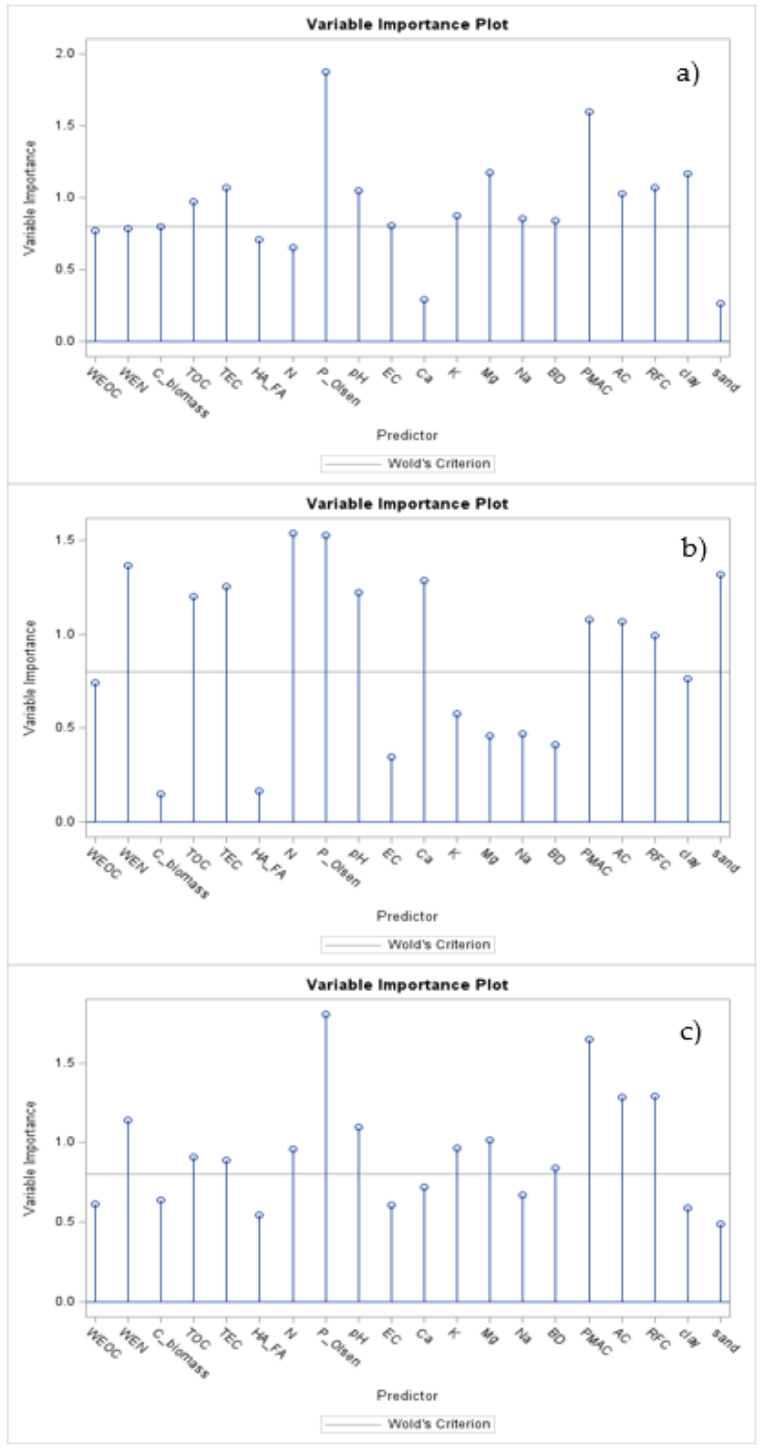
Figure 3. Variable importance for projection statistics (PLS-VIP) obtained using as response variable in PLSR ( a ) wheat grain yield, ( b ) grain protein content and ( c ) both variables. The horizontal black line indicates the threshold of 0.8 to discriminate and select significant variables according to Wold criterion.